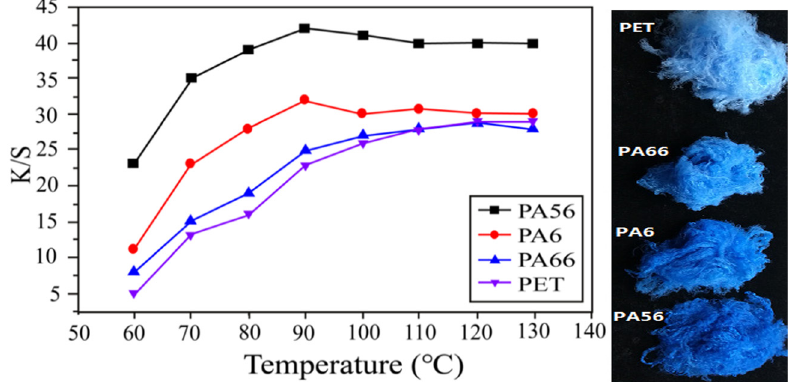
Figure 2: Dyeing property of dispersed dyes for several kinds of fi bers ( 44 dtex/36 f FDY )